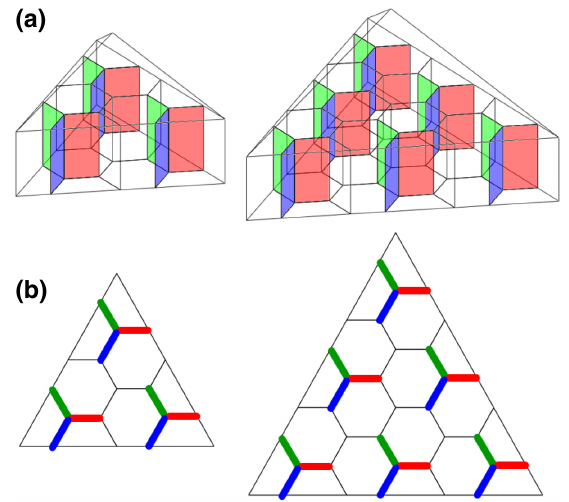
FIG. 7. (a) Vertical face generators e z of capped color codes CCC ( d ) with d = 5 (left) and d = 7 (right) and e x act on the same set of qubits). The operators of each ( e z r + i i code can be represented by edges on a 2D color code, as shown in